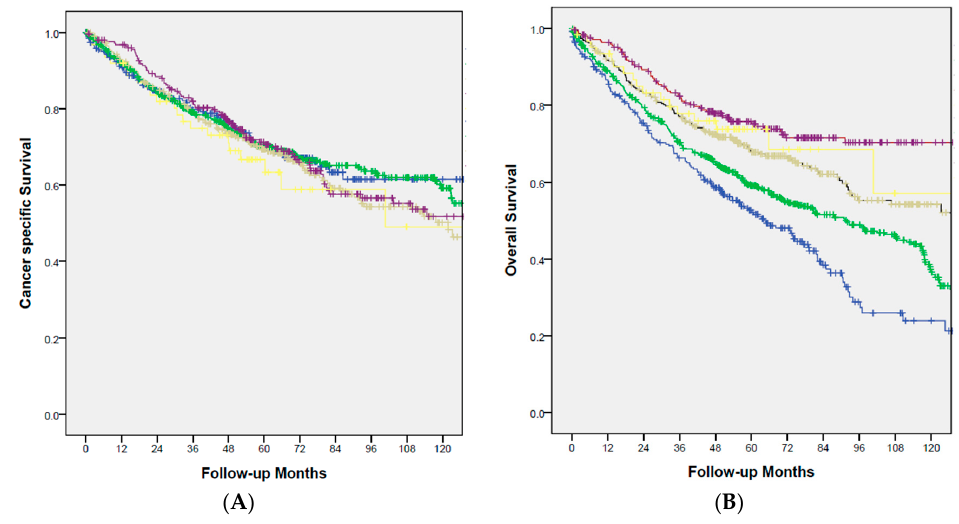
Figure 3. ( A ) Cancer-specific survival stratified by different age groups. ( p = 0.731m, <50: yellow; 50–60: red; 60–70: gray; 70–89: green; >80: blue); ( B ). Overall survival stratified by different age groups. ( p < 0.001; <50: yellow; 50–60: red; 60–70: gray; 70–89: green; >80: blue).